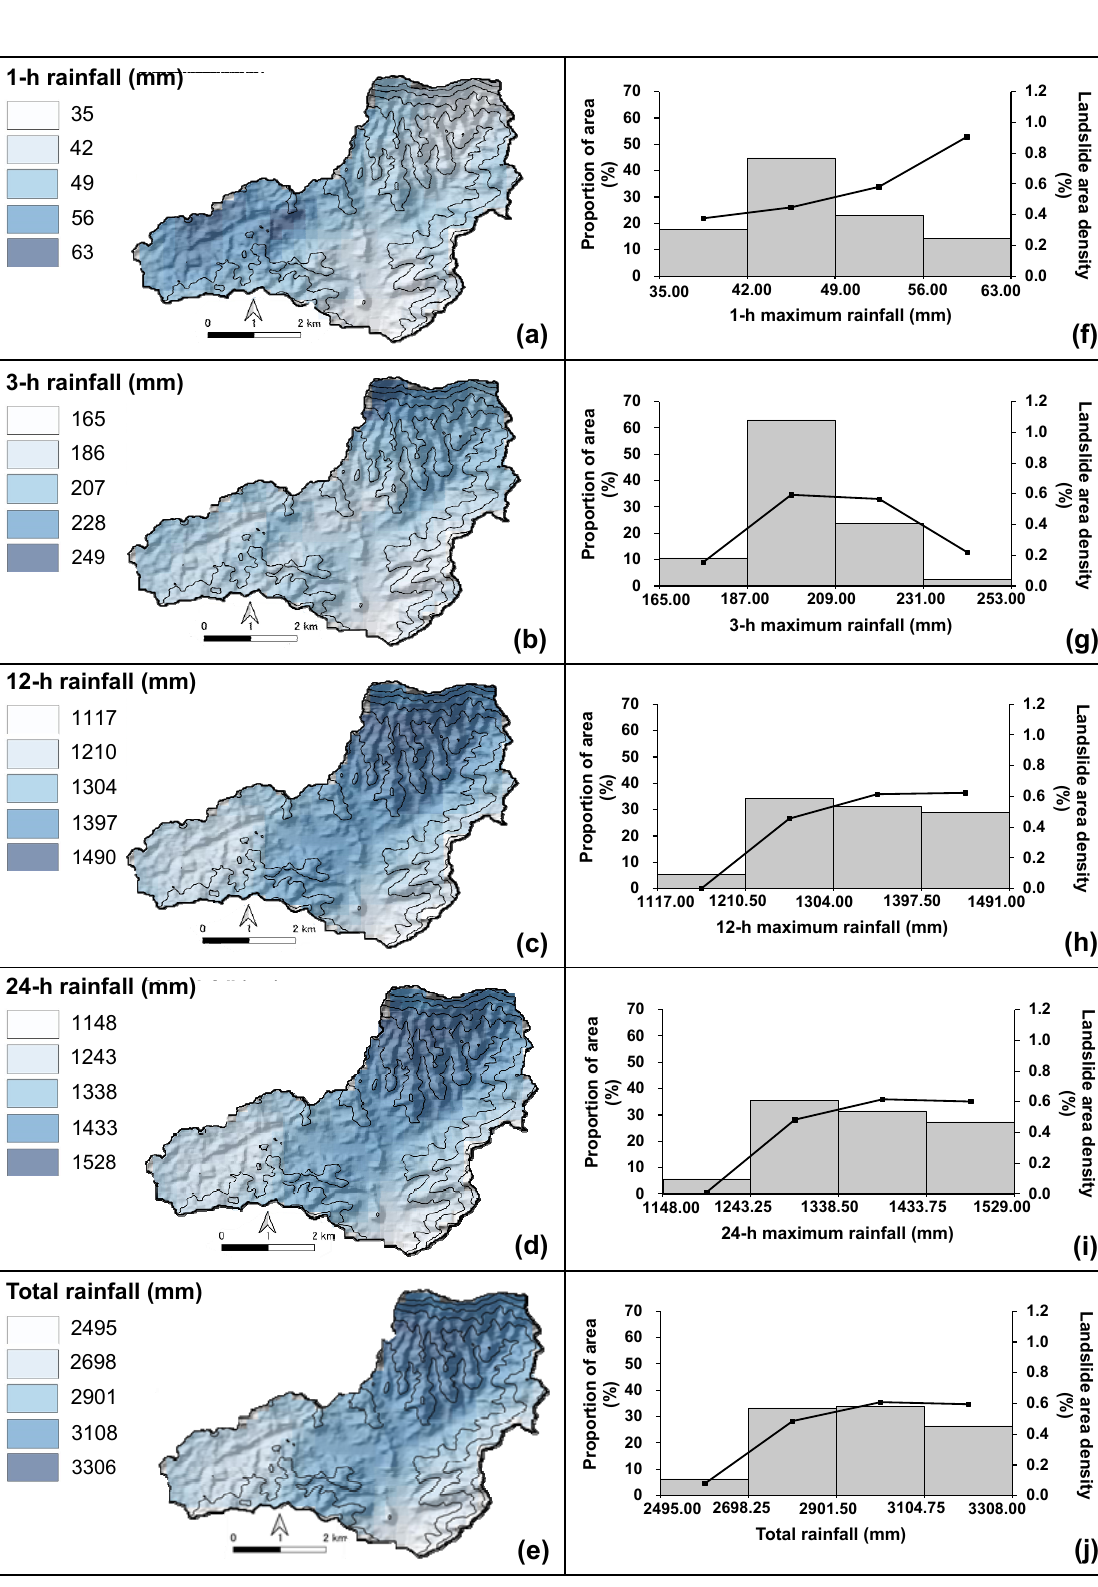
Figure 5. ( a – e ) Rainfall distributions measured by the X-band MP radar network and ( f – j ) the proportion of areas (bars) and landslide area density (lines) for the 1-h ( a , f ), 3-h ( b , g ), 12-h ( c , h ), and 24-h maximum rainfall ( d , i ) and total rainfall ( e , j ).